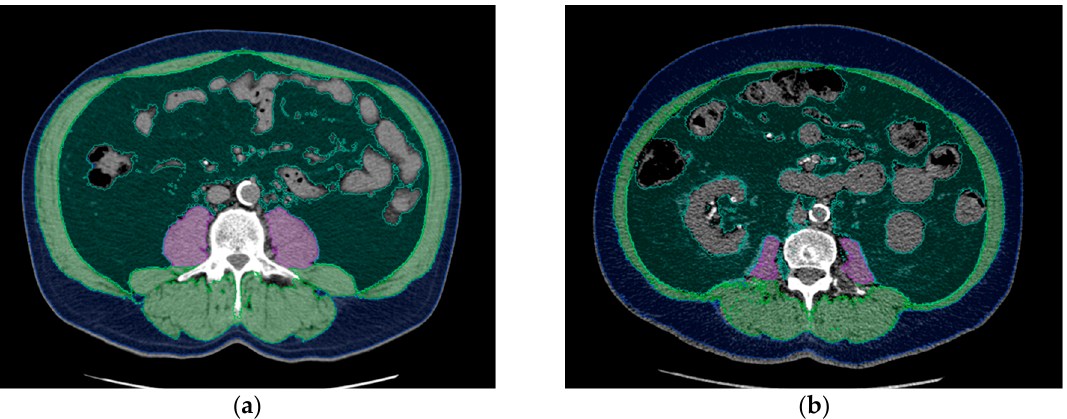
Figure 1. Examples of AI-based analysis of body composition: ( a ) 65-year-old male kidney transplant recipient with a BMI of 27.7, PMI of 9.8, and SMI of 67.6. ( b ) 65-year-old male kidney transplant recipient with a BMI of 27.8, PMI of 3.9, and SMI of 44.4. Even though both patients are the same age and have almost the same BMI, their body composition parameters are considerably different. Each segmented tissue is coded with a different color: psoas muscle = purple, skeletal muscle (except psoas muscle) = green, visceral fat = dark green, blue = subcutaneous fat. Tissue density and area were automatically calculated using Visage version 7.1.